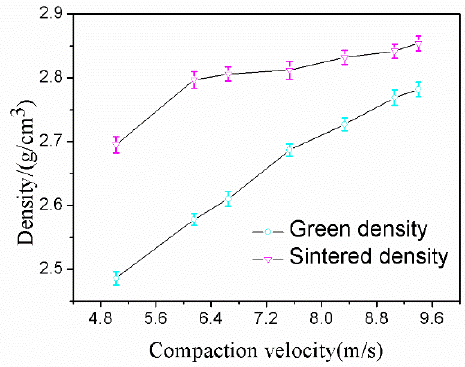
Figure 6. Density versus compaction velocity.